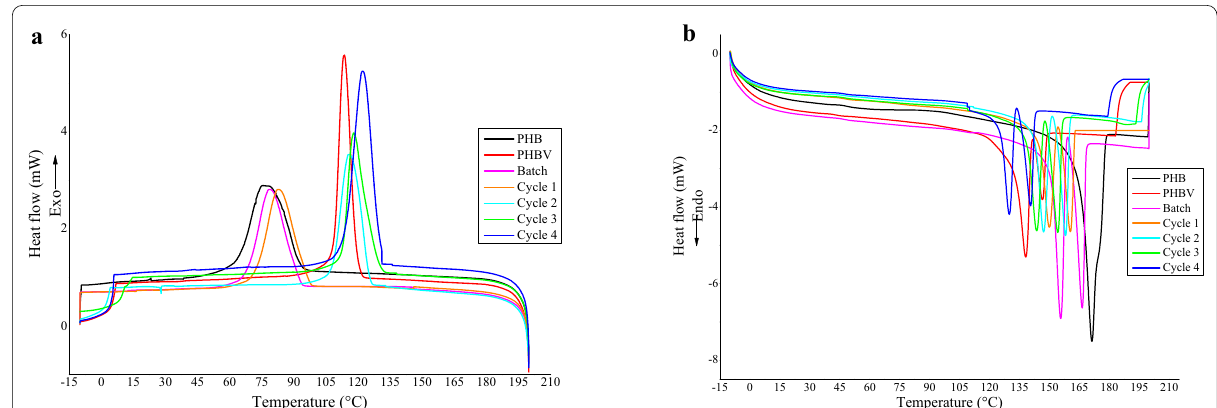
Fig. 6 DSC thermogram displaying the cooling cycle ( a ) and the second heating cycle ( b ) used to characterize commercial PHB and PHBV, and the PHA extracted from B. thuringiensis after each cycle of the cyclic fed-batch